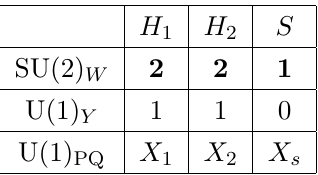
Table 1 . The scalar field contents and their quantum